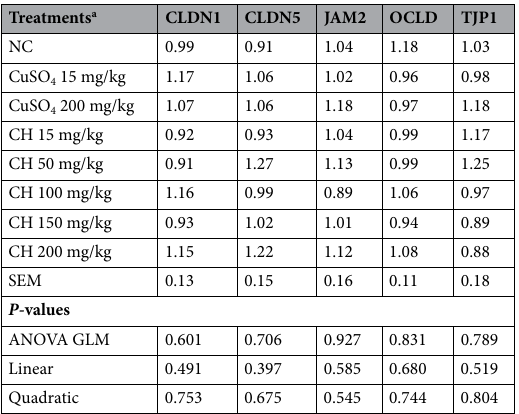
Table 10. Effect of dietary treatments on expression of jejunal tight junction genes a . Mean values are based on 3 birds per replicate and 6 replicates per treatment. a NC Negative control, no added Cu, CH